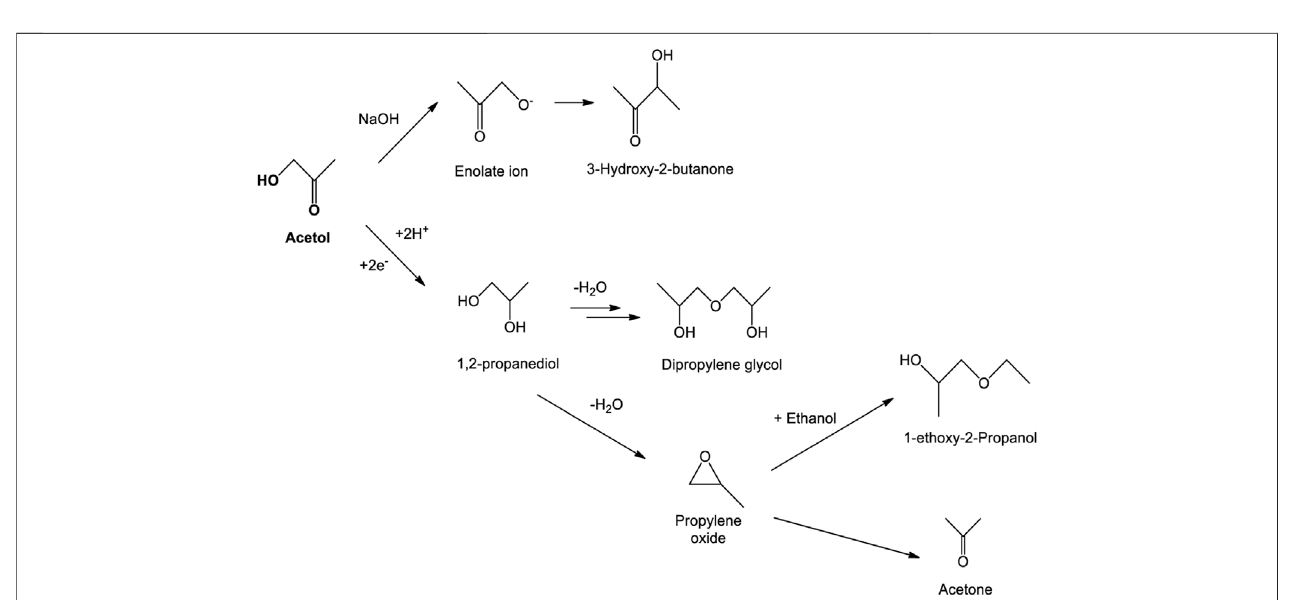
SCHEME 1 | Formation of 1,2-propanediol and by-products from acetol electrolysis.